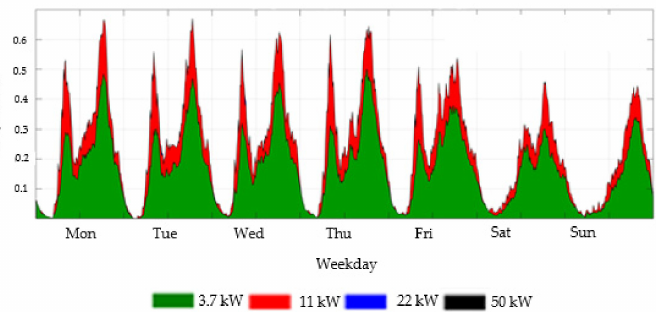
Figure A19. Charging Patterns for uncontrolled charging for both “home and workplace charging”. This might lead to the hypothesis that the temporal charging in Clusters 2 and 3 mainly covered home charging, temporal charging in Clusters 1 and 7 mainly workplace charging, and in Cluster 6 public charging. Since the user groups were composed of the shares of the temporal charging clusters (see Figure A10), User Group A might be rather home chargers, User Group C workplace chargers, and User Group E mostly public short-term chargers. Thus, possible charging locations could be assigned to the three user